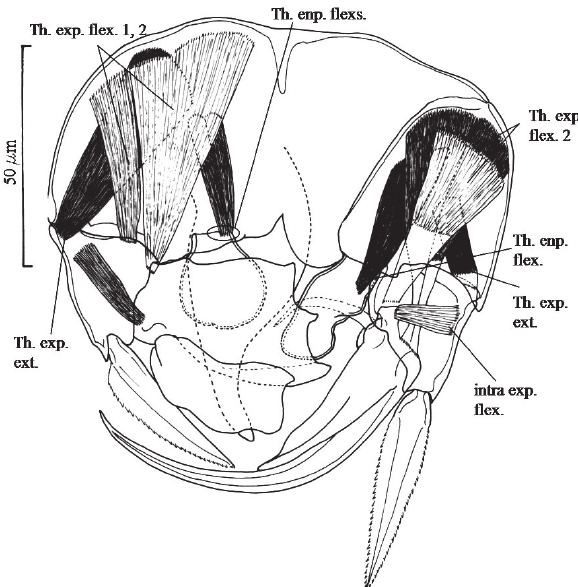
Fig . 7. – fifth leg pair of male P. xiphophorus from lake faro. posterior view, showing intrinsic musculature to rami on both sides. (plumose setae on protopodal segments omitted for clarity.) abbre- viations: enp, endopodal; exp, exopodal; ext, extensor; flex, flexor, flexs, flexors, intra, intra, th,